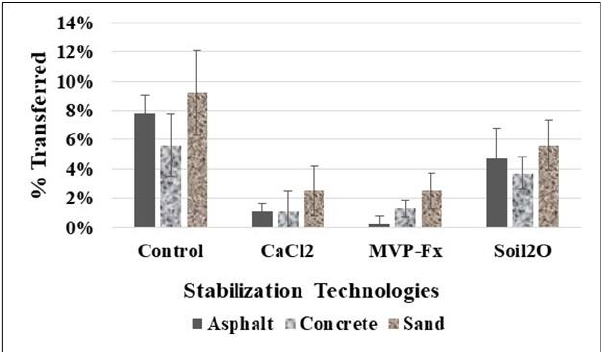
Figure 11. Percent Transfer of Sr-85 Contaminated Particles for Vehicle Experiments.